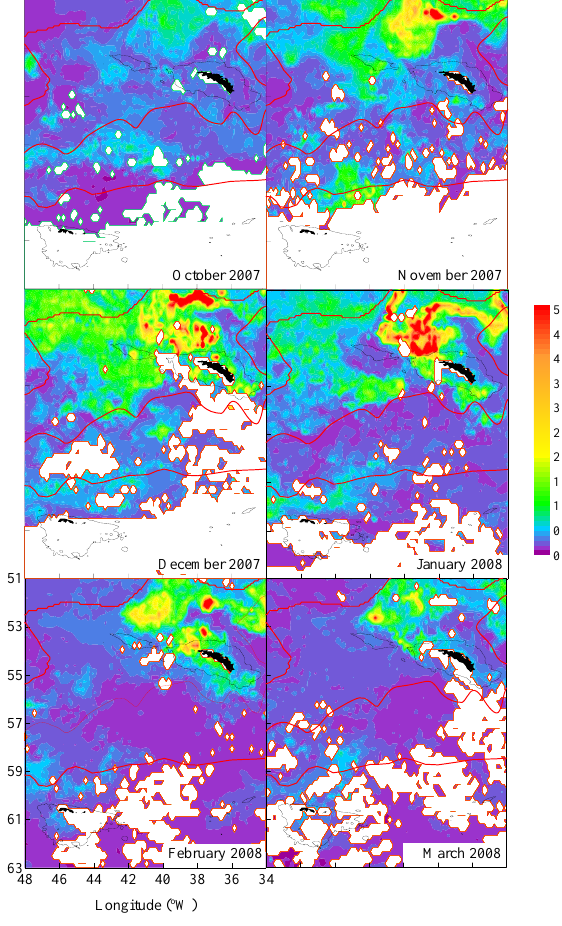
Fig. 6. Monthly composites of MODIS-Aqua Chl a concentrations (mgm − 3 ) in the Scotia Sea from October 2002 to March 2003. White areas indicate clouds and/or sea-ice. Frontal positions are marked as thin red